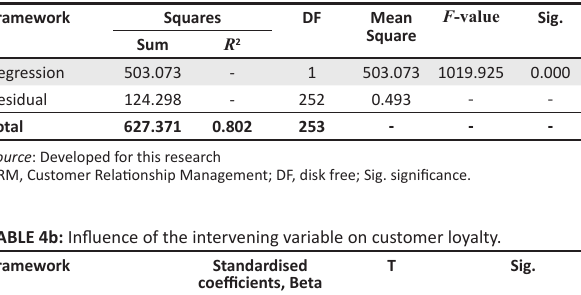
TABLE 4b: Influence of the intervening variable on customer loyalty.